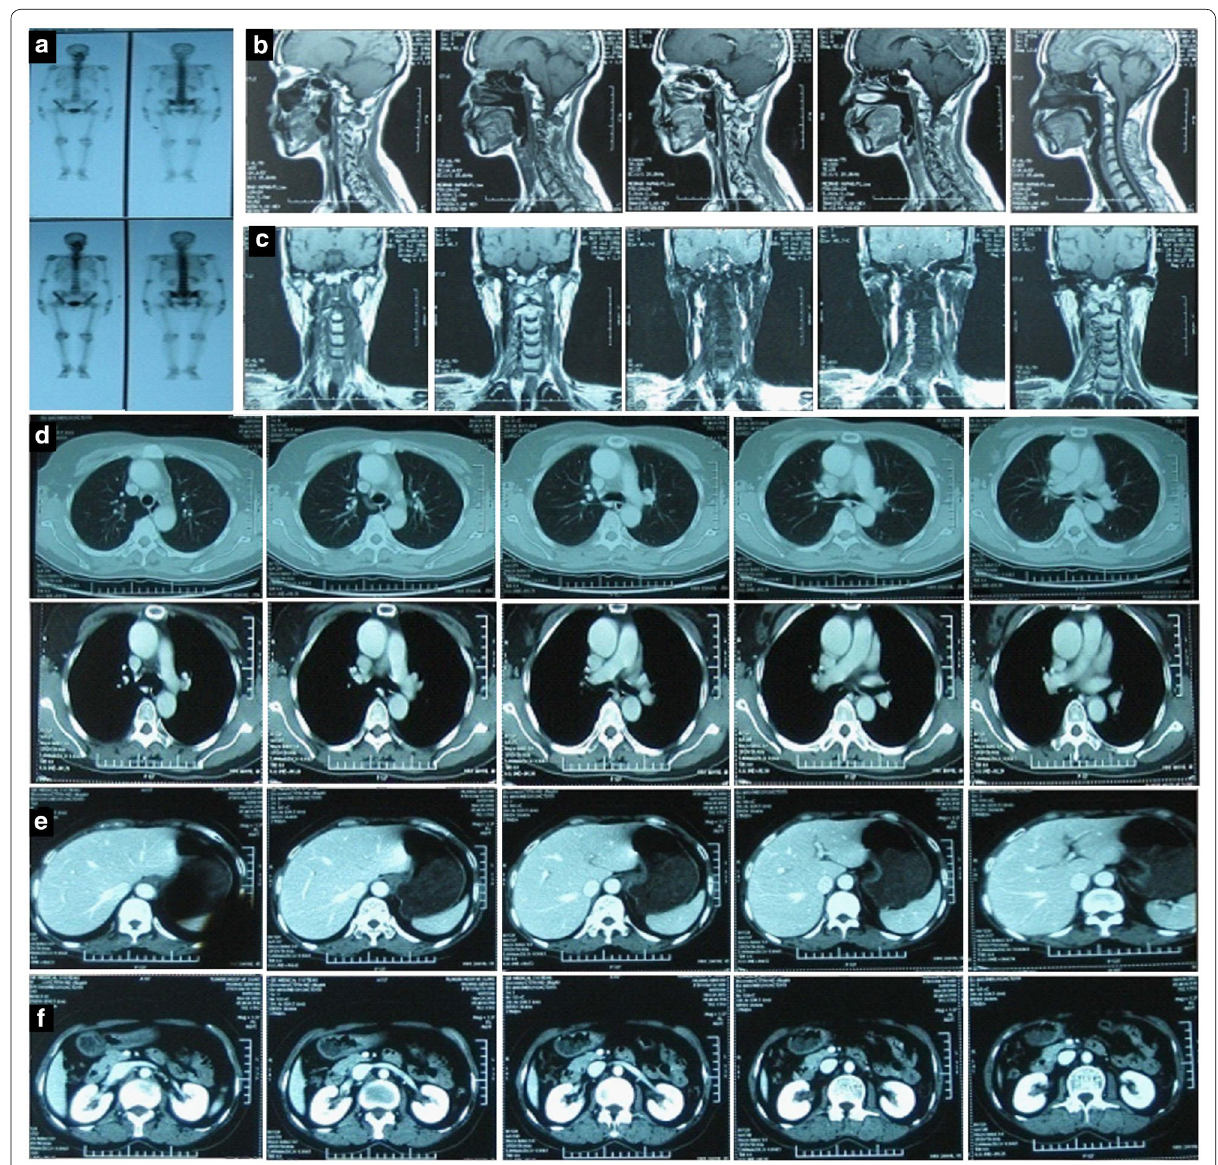
Fig. 3 Examination of an NPC patient 20 years after 50 Gy radiotherapy plus HPD. a whole body bone scan image without abnormally increased uptake; b nasopharyngeal neoplasm disappears on nasopharyngeal magnetic resonance image (MRI); c cervical lymph node metastases are not found on cervical MRI; d chest computed tomography (CT) is normal; e upper abdominal CT without any abnormal lesion; f metastases are not found on lower abdominal